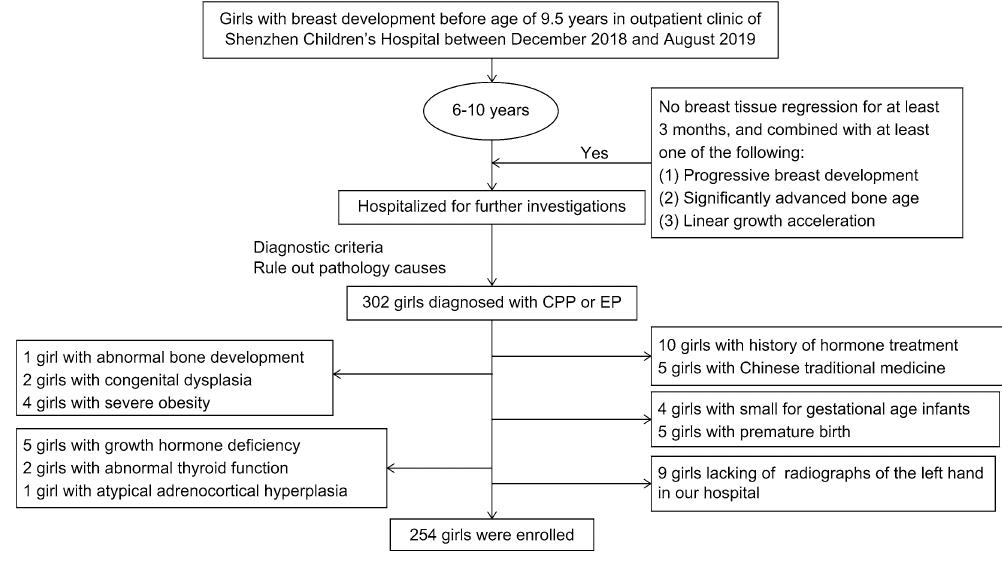
Figure 1. Flowchart of the population selected for the